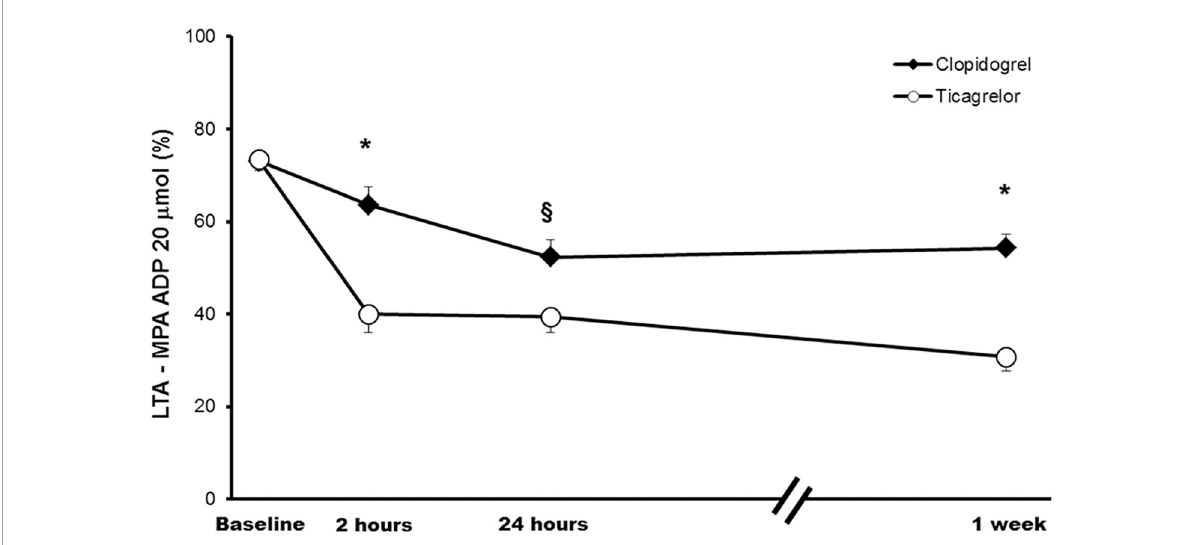
FIGURE3 Platelet reactivity across study time points. Comparison of platelet reactivity over time measured with LTA and using 20 µ mol ADP as agonists (primary endpoint). Values are expressed as least-squares means. Error bars indicate standard errors of the mean. * p < 0.001; § p < 0.05. ADP, adenosine diphosphate; LTA, Light transmission aggregometry, MPA, maximal platelet aggregation.